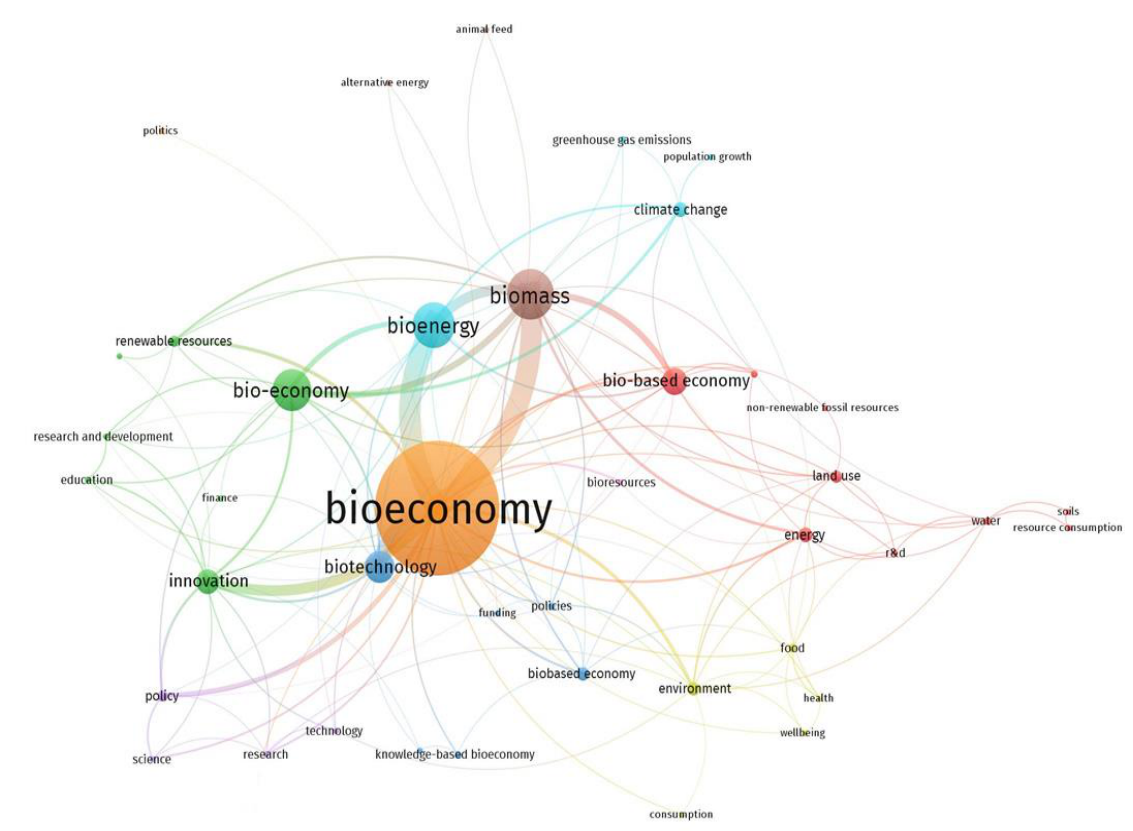
Fig. 2. Links from SCOPUS scientific publications with selected 24 bioeconomy affecting